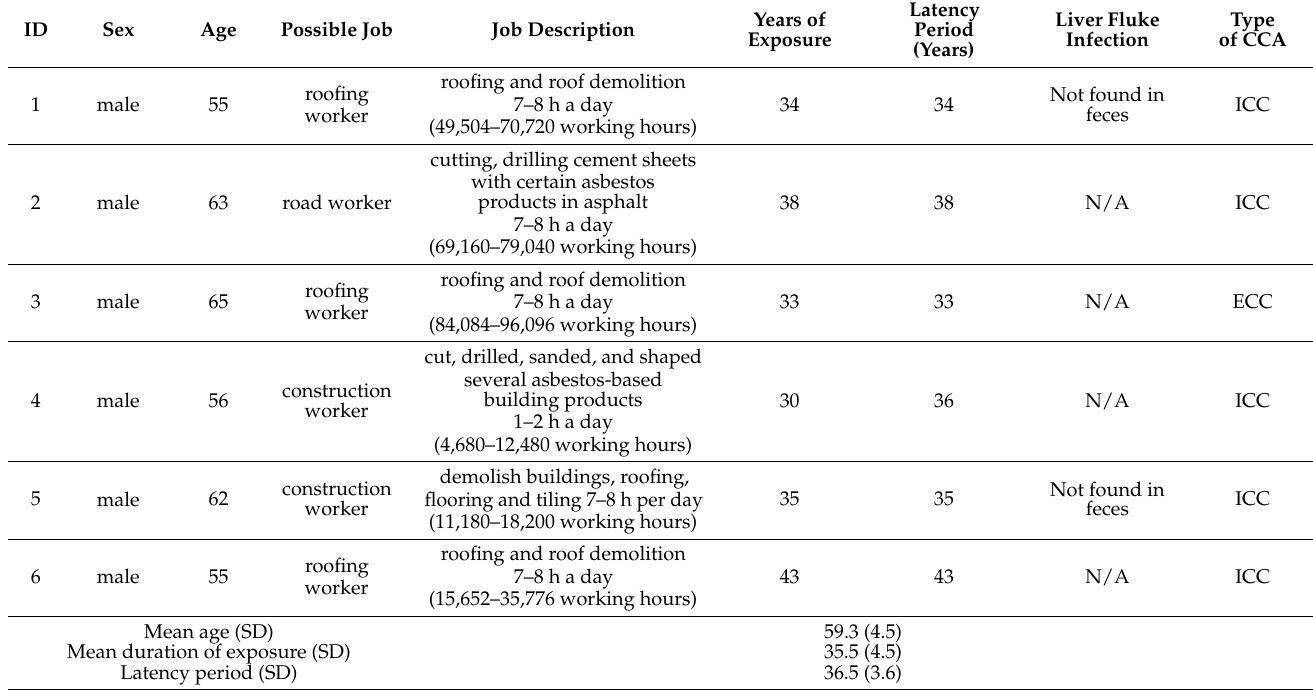
Table 4. Characteristics of participants exposed to asbestos diagnosed as possible occupationally related CCA ( n =